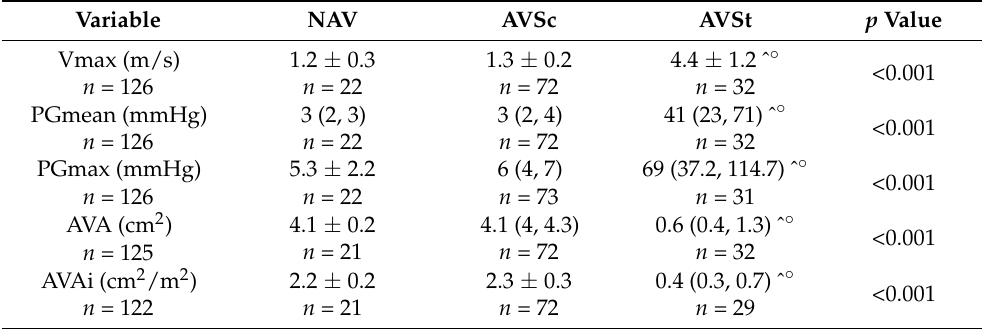
Table 2. Parameters evaluated from the echocardiogram that depict the valve function. Data are shown as mean ± standard deviation, or median (percentile 25, percentile